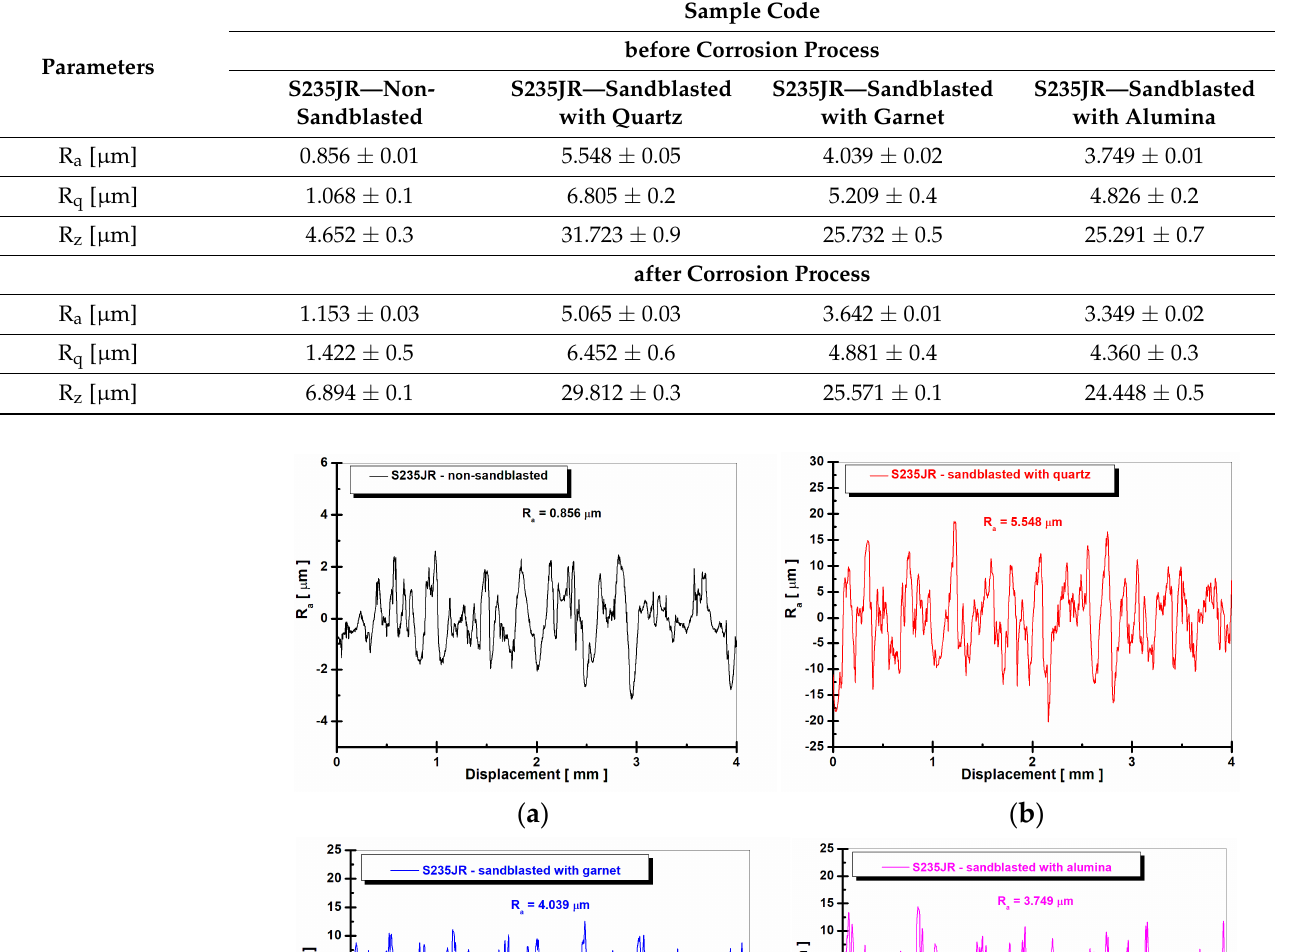
Table 5. Roughness parameter values for the tested surfaces before and after the corrosion process.